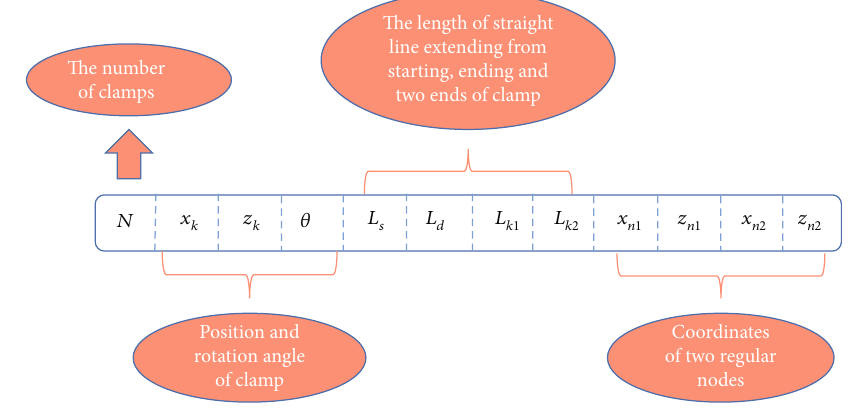
Figure 7: Individual coding form. Table 1: Results of the multiobjective algorithms (using